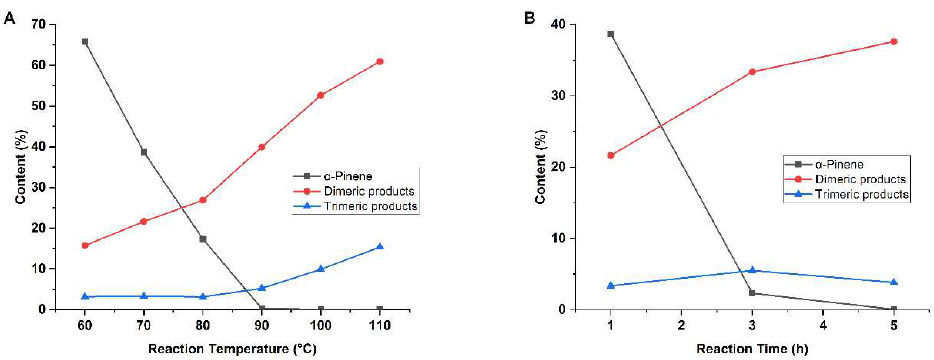
Figure 1. Effect of reaction temperature and reaction time on the conversion of α-pinene and yields of dimeric and trimeric products. The reaction was carried out ( A ) for 1 h and ( B ) at 70 ° C.